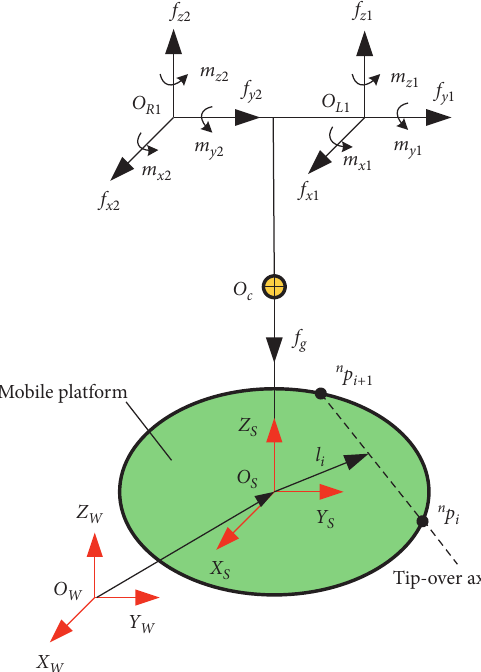
Figure 3: Force and moment model of the